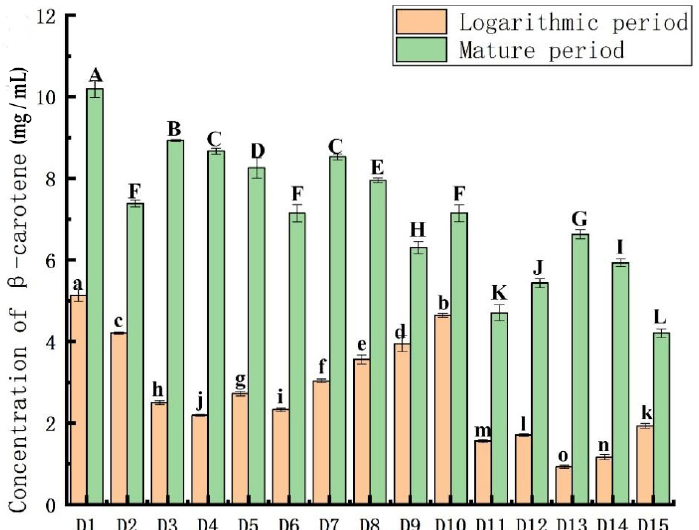
Figure 4. Comparison of β -carotene content in the 15 Dunaliella strains. The letters a–i and A–L in the figure represent the single-factor significant difference analysis of the β -carotene content in 15 Dunaliella strains at the logarithmic and mature stages, respectively. When the letters marked on different Dunaliella species are the same, it means that there is no significant difference between them, and when the letters are different, there is a significant difference.